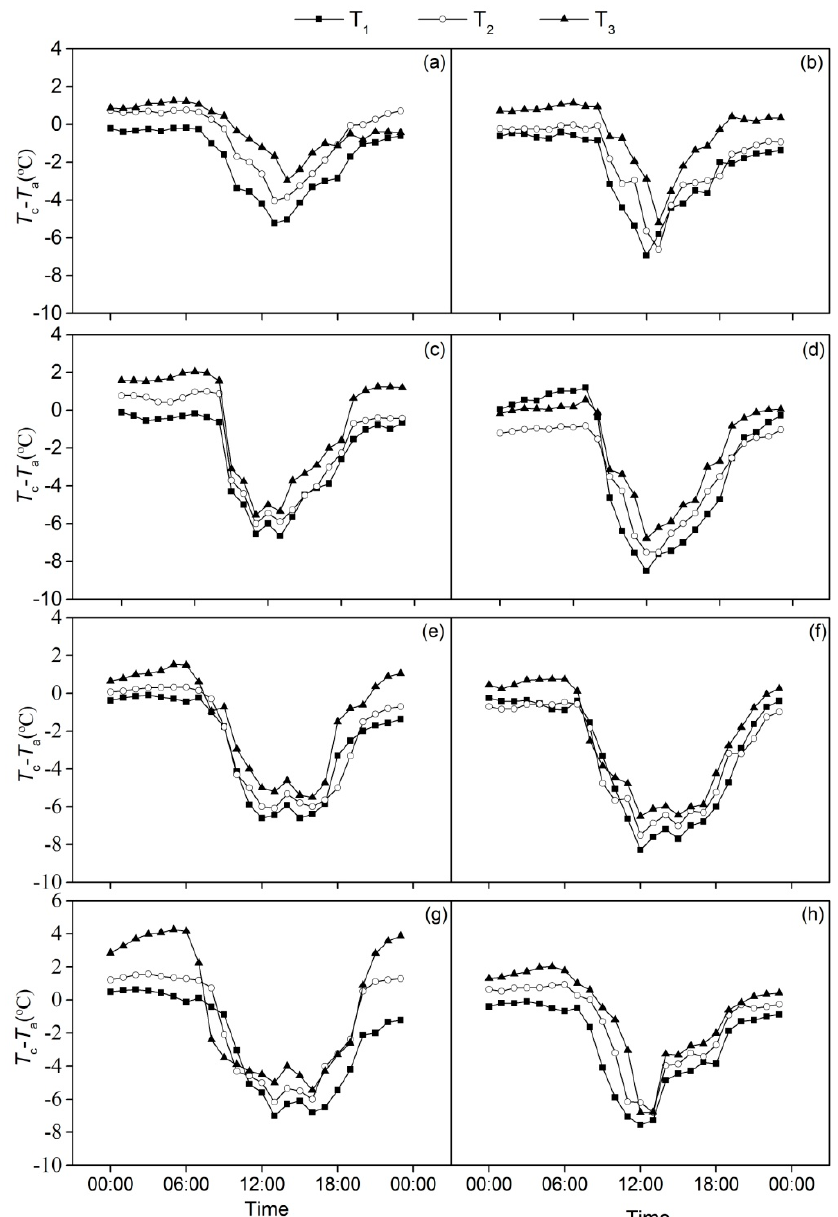
Figure 1. Daily change in the leaf-air temperature difference before and after irrigation at different stages. ( a , b ) represent the vegetative stage; ( c , d ) represent the flowering stage; ( e , f ) represent the fruit expansion stage; and ( g , h ) represent the mature stage. ( a , c , e ), and ( g ) represent T c - T a before irrigation, while ( b , d , f , h ) represent T c - T a after irrigation. T 1 represents 100% M, T 2 represents 80% M, T 3 represents 60%.